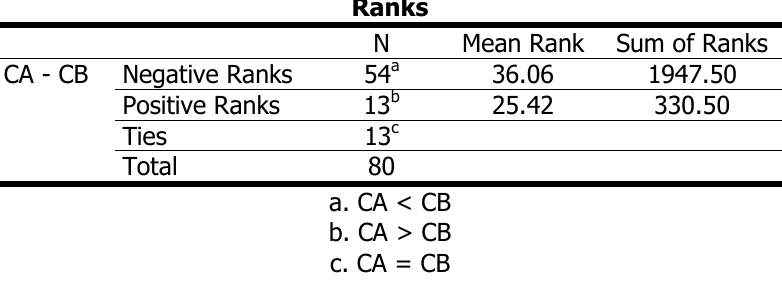
Table 5. Wilcoxon Signed Ranks Cultural Motivation Test